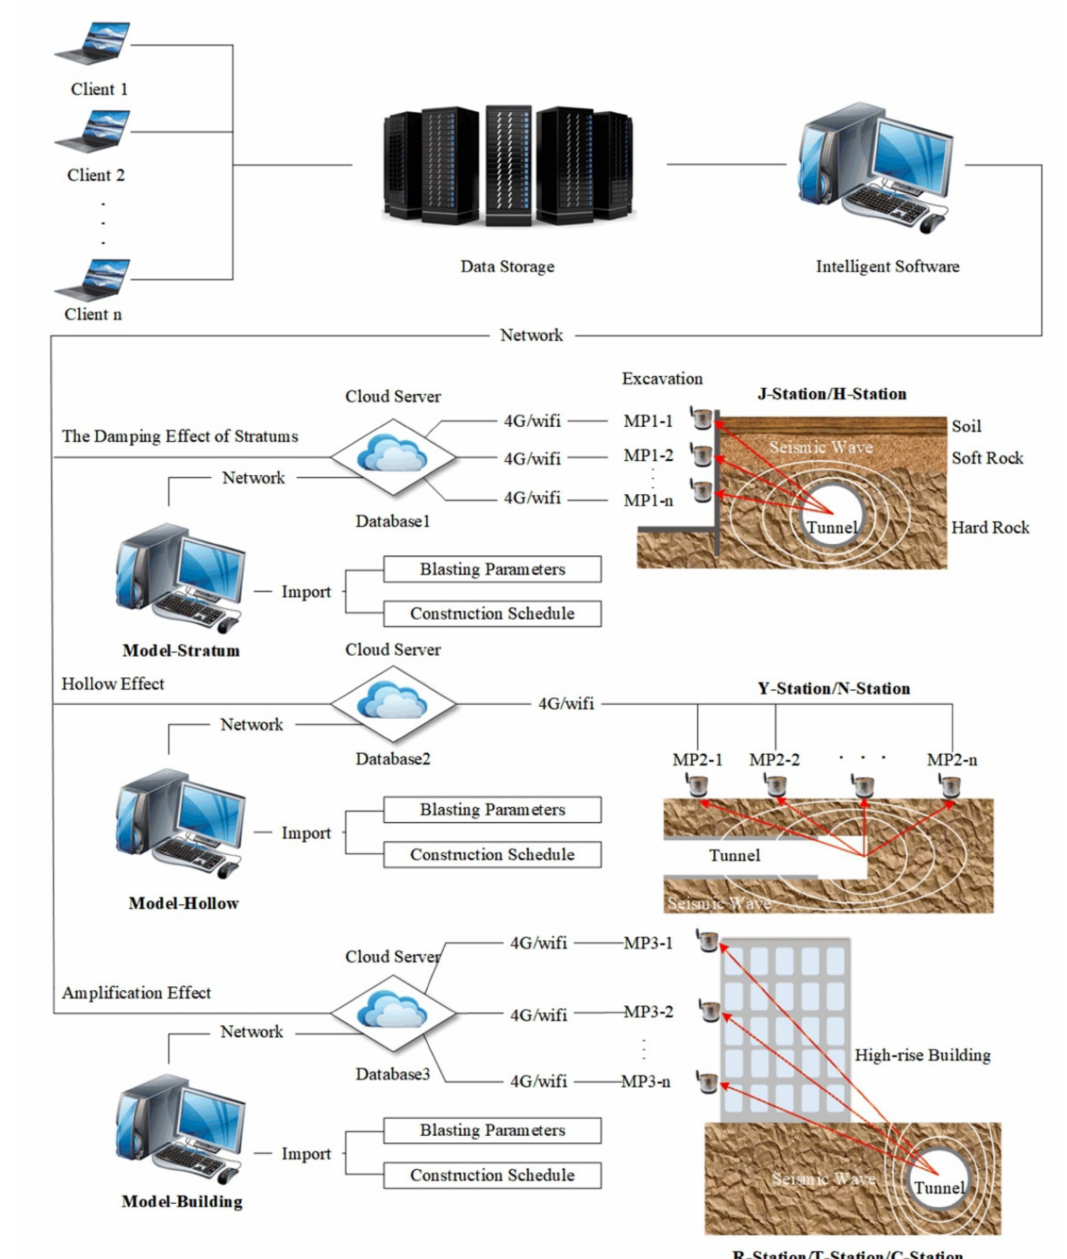
Figure 8. Network topological map of the monitoring